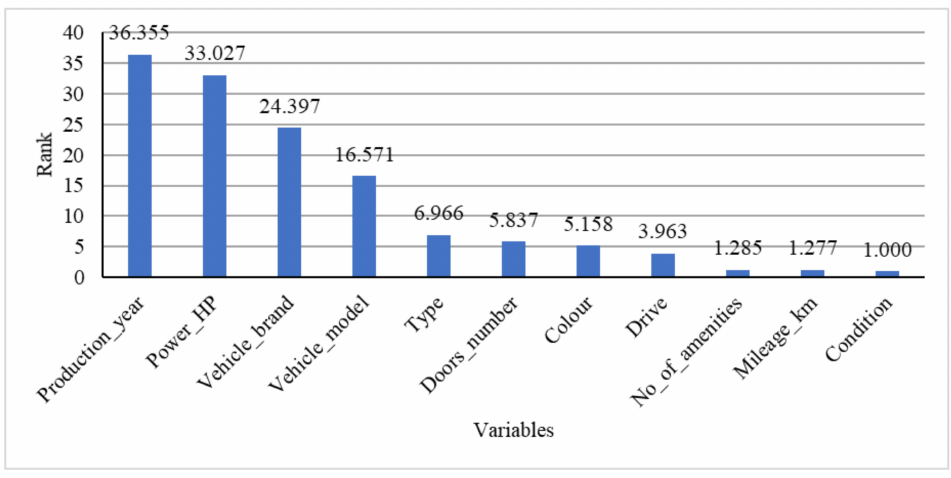
Figure 10. The results of the sensitivity analysis for the Id 44 network (MLP